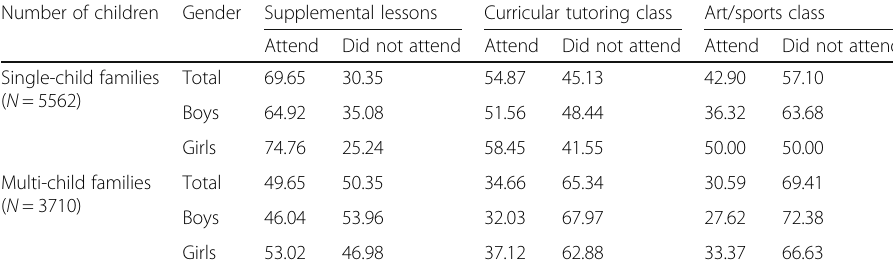
Number of children Gender Supplemental